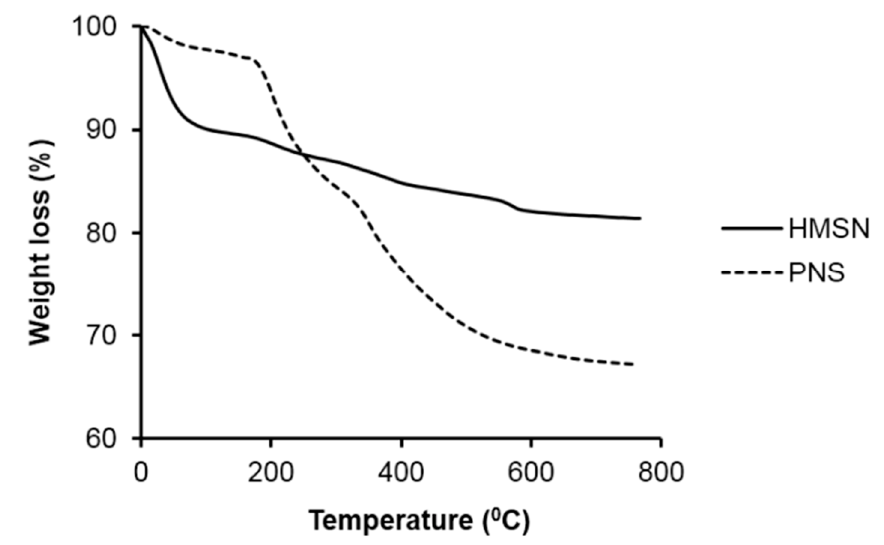
Figure 3. Thermogravimetry analysis for PNS ( a ) and HMSN ( b